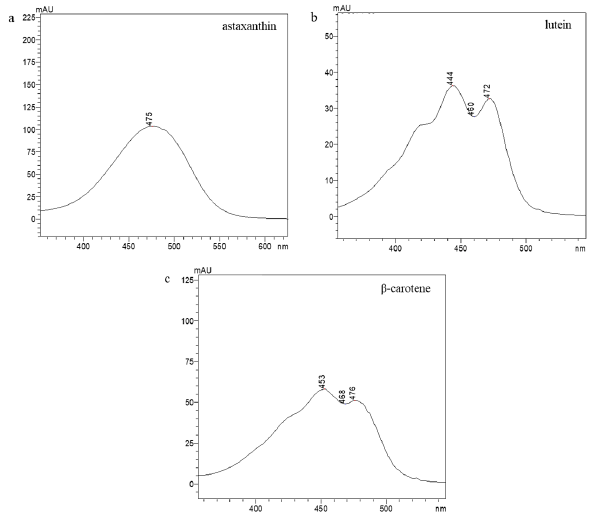
Figure A1. Absorbance spectra of ( a ) astaxanthin; ( b ) lutein and ( c ) β -carotene.